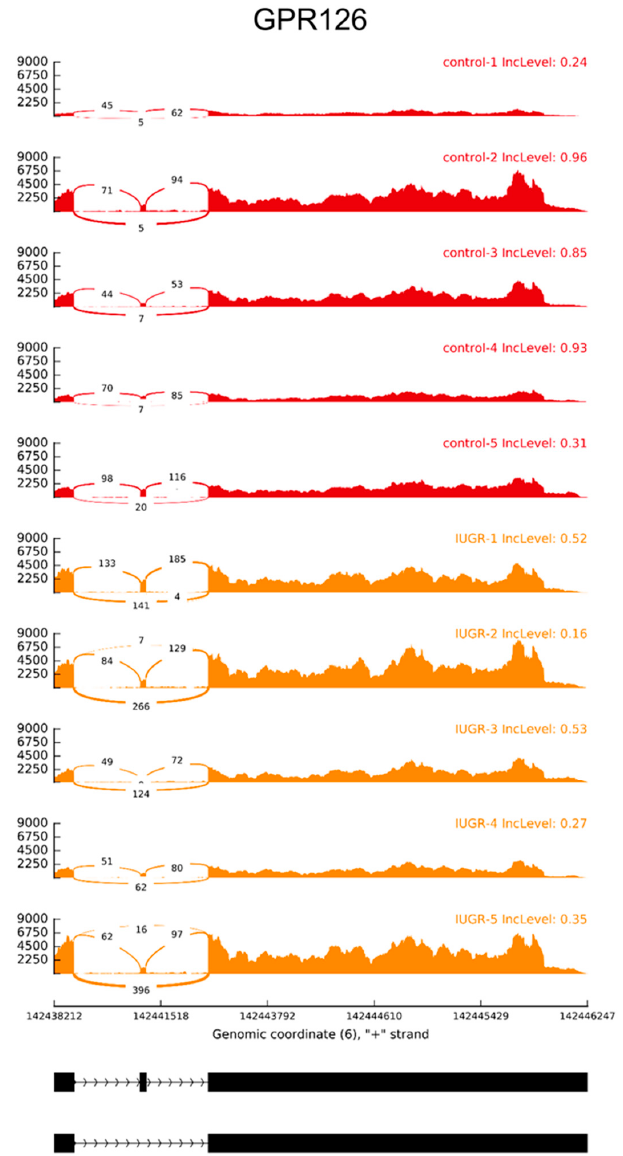
Figure 5. Quantitative visualization (Sashimi plot) of an alternative skipping event of exon 23 (E23) within the GPR126 ( ADGRG6 ). Ten upper tracks represent biological replicates for control (red) and IUGR (orange) libraries. Numbers on curved lines indicate counts engaged in each splice junction. The scale on left present coverage depth of GPR126 in range of ASE region. Percent splicing inclusion (PSI) present on the right side of each sample in the upper track. Middle track depicts genomic coordinates of ASE on chromosome 6. The bottom track represents exon-intron structures of DAS event in the range of E23.